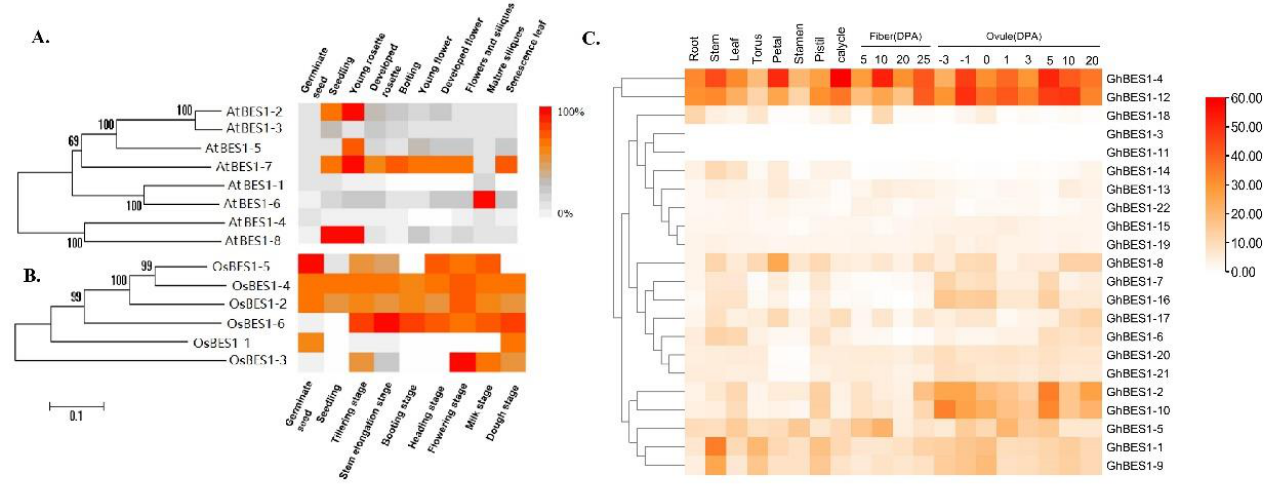
Figure 3. Heat map of AtBES1 , OsBES1, and GhBES1 family genes expression in different growing stages or tissues. ( A ) Arabidopsis ; ( B ) rice; ( C ) G. hirsutum .